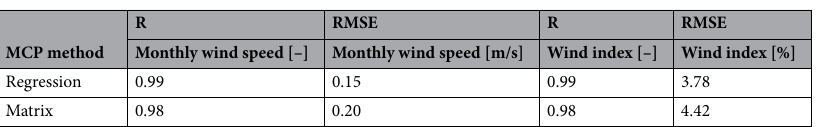
Table 2. Comparison of accuracy between MCP methods.